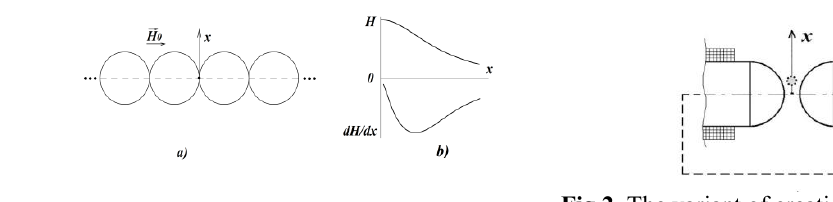
Fig.1. The chain of balls in field of solenoid with intensity H 0 ( а ) and corresponding illustration of coordinate (along x ) characteristics [14-17] of intensity H and nonuniformity dH / dx of field at wedgegap between the spherical pole surfaces ( b )